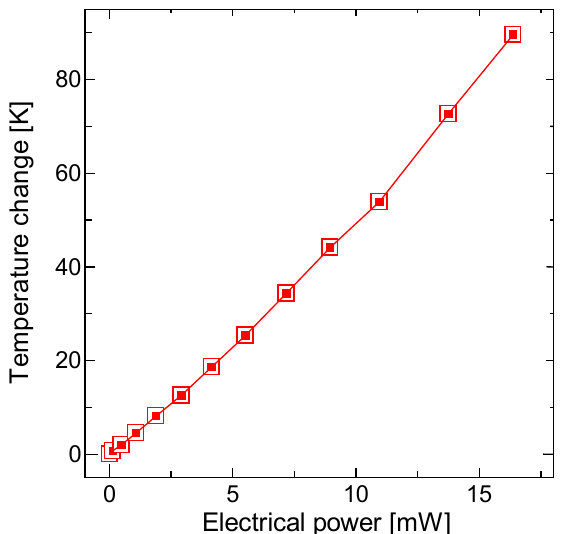
Figure 9. Measured temperature change versus applied electrical power for each bimorph. The temperature rise at the NiCr/SiN bimorph was measured using infrared thermography. The power applied to one bimorph was estimated from the total power.